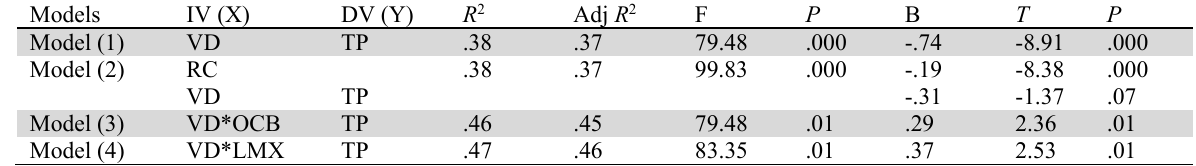
Regression Analysis of Value Diversity, Relationship Conflict, Team Performance, OCB and